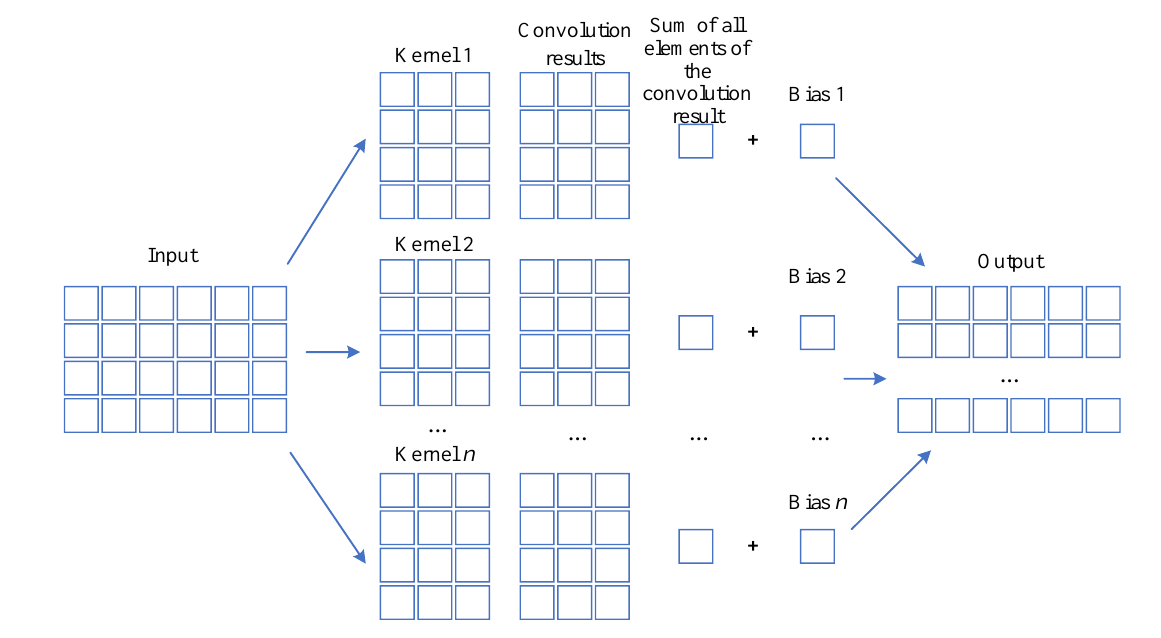
Figure 1. Schematic diagram of the 1DCNN process.